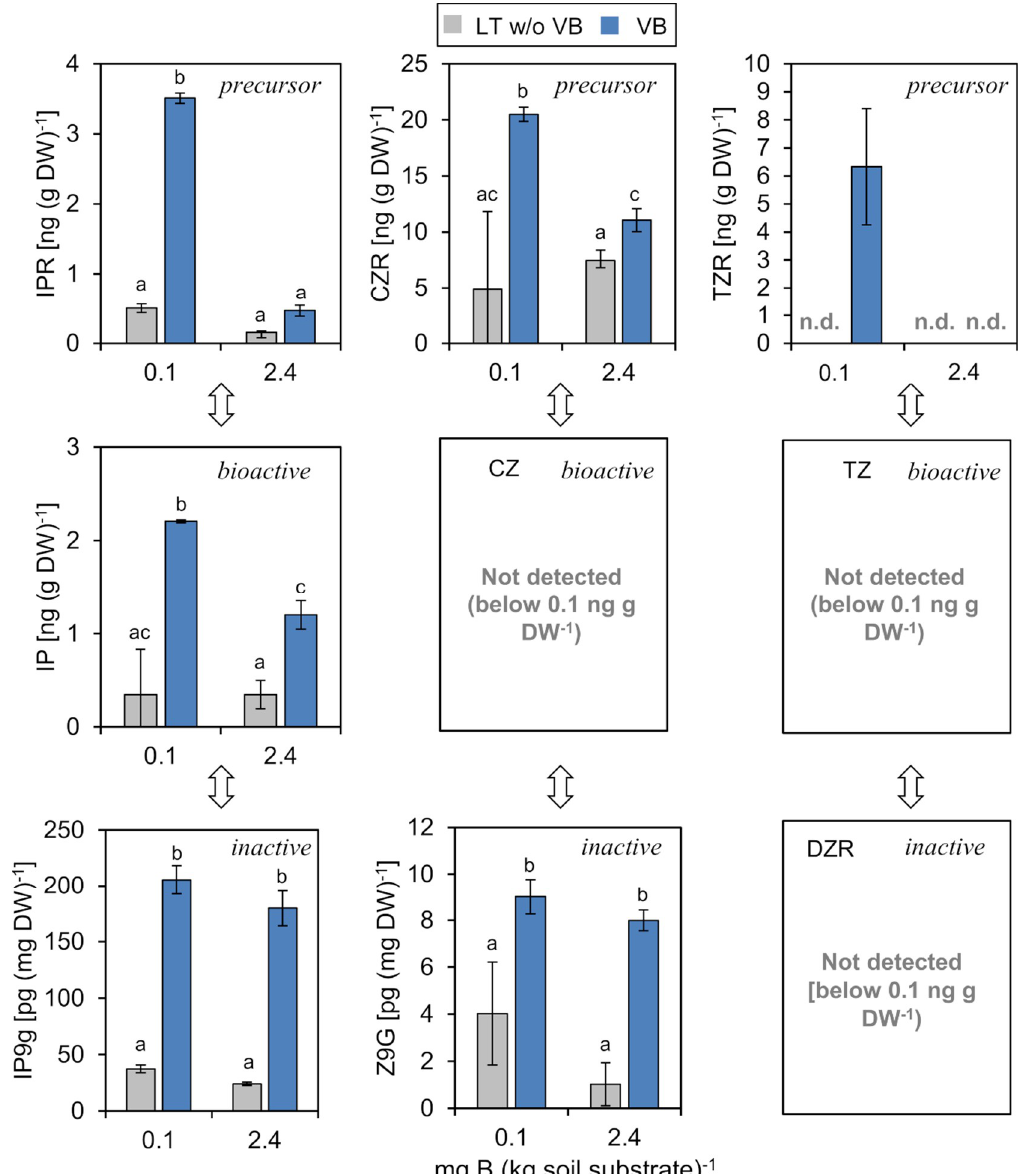
Figure 5. Concentrations of precursor, bioactive, and inactive cytokinin species in separated vascular bundles (VB) or leaf tissue without VB (LT w/o VB) of P. major plants grown in B-deficient (0.1 mg B (kg soil substrate) −1 ) or B-sufficient (2.4 mg B (kg soil substrate) −1 ) soil conditions. Arrows indicate biosynthetic conversions of the depicted cytokinin species. Bars represent averages from three different measurements ± SD. Abbreviations: DW = dry weight, IPR = Isopentenyladenine-riboside, CZR = cis -zeatin-riboside, TZR = trans -zeatin-riboside, IP = Isopentenyladenine, CZ = cis -zeatin, TZ = trans -zeatin, IP9g = Isopentenyladenine N9 -glucoside, Z9G = Zeatin N9 -glucoside, n.d. = not detected. Error bar labels with different letters indicate significant differences at p < 0.05 between treatments and tissues according to One-way ANOVA with post-hoc Tukey test.